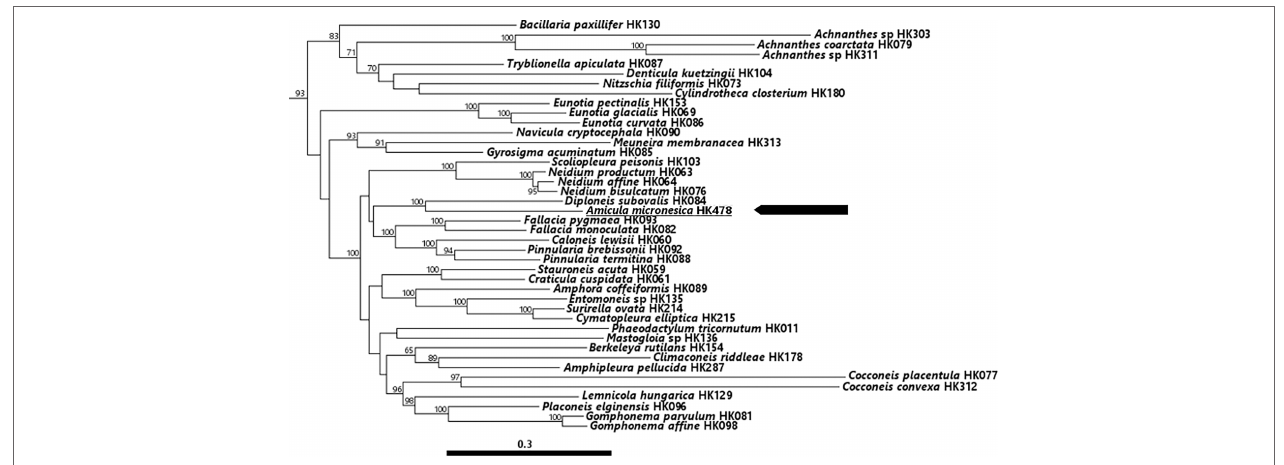
FIGURE 5 | Maximum likelihood phylogenetic tree obtained from the 7-gene dataset. The tree with the best likelihood (-354816.345467) is